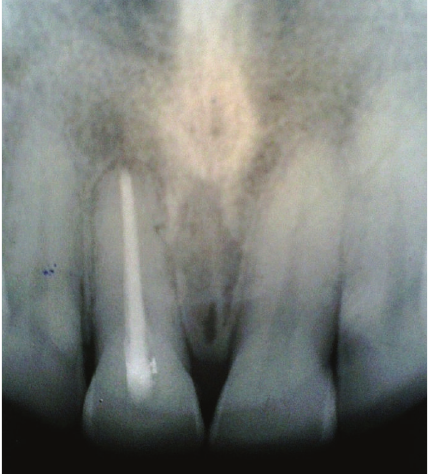
Figure 5: Postoperative radiograph revealing complete healing of the defect at 1-year recall visit.